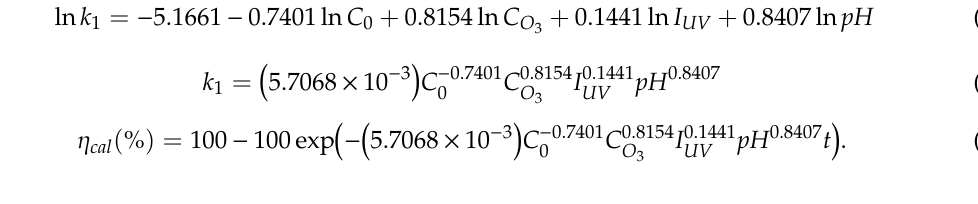
Table 2. Multiple regression analysis result.